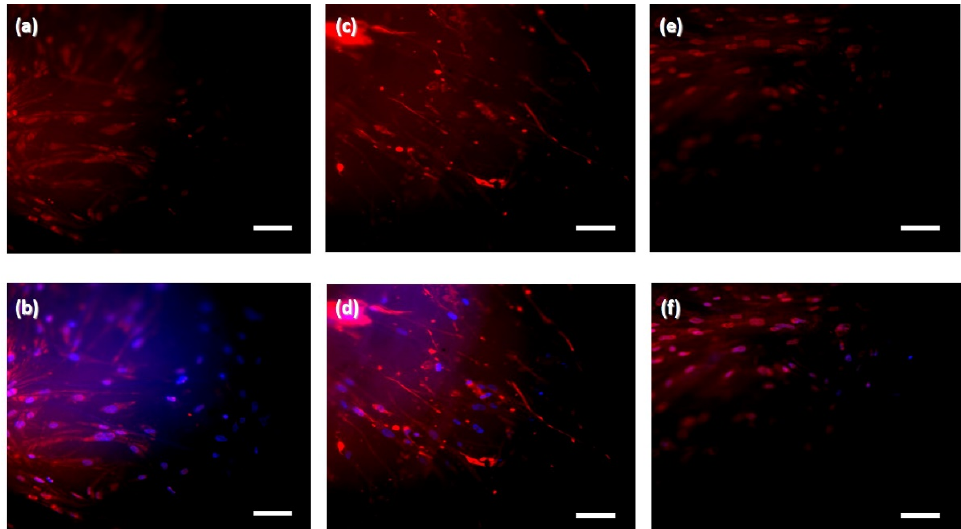
Figure 3. Immunofluorescence staining of human adipose stem cells cultured on bacterial cellulose scaffold for 14 days. ( a , b ) Octamer-binding protein 4 (OCT-4) and OCT-4/Hoechst overlay expression, respectively. ( c , d ) Nestin and Nestin/Hoechst overlay expression, respectively. ( e , f ) Sex determining region Y-box 9 (SOX-9) and SOX-9/Hoechst overlay expression, respectively (scale bar = 200 μm) .